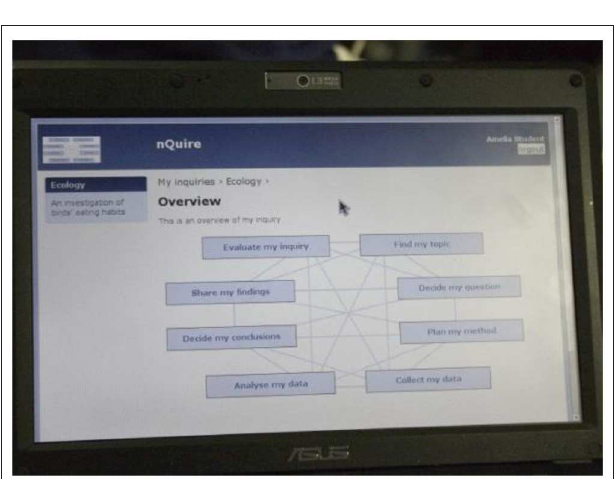
FIGURE 6 | The personal inquiry toolkit (PI toolkit, or nQuire) when used in the trials of the third year.